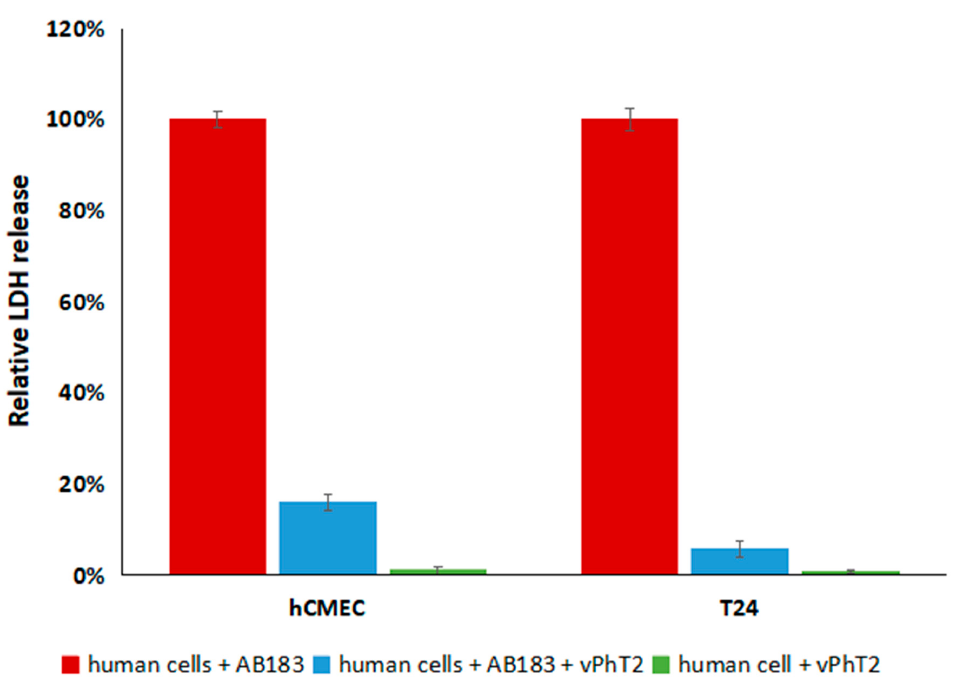
Figure 5. Normalised lactate dehydrogenase levels (LDH) (OD 490 - OD 680 ) released by T24 and hCMEC / D3 human cell lines treated with Acinetobacter baumannii AB183 and or vPhT2 over 24 h (N = 3). Treatment of human cells with only AB183 represent 100% relative cytotoxicity. LDH levels produced by human cell negative controls with no treatment are representative of 0% cytotoxicity.